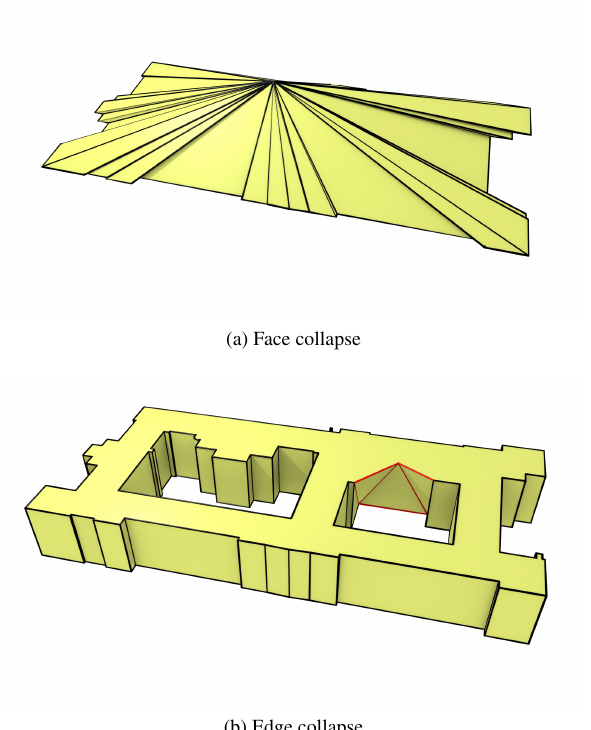
Figure 6: Cells can be collapsed by moving all of their vertices to the same location. Shown here are the collapse of (a) a face and (b) an edge on the top facet of the prism. The modified edges in (b) are highlighted in red. Note how among the modified edges, one edge that is not incident to the collapse vertex (plus another one hidden from this view) is added in order to triangulate a non- planar